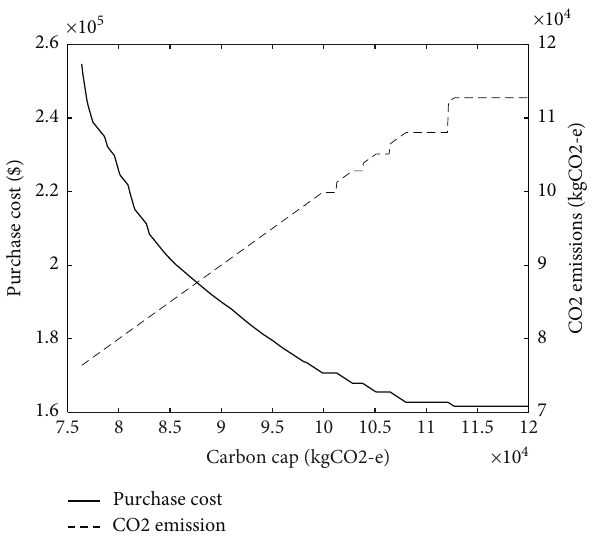
Figure 6: Purchase cost and CO cap.